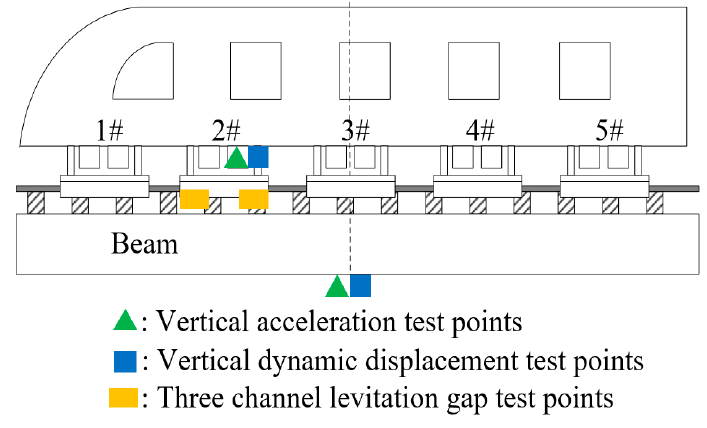
Figure 6. Arrangement of test points.